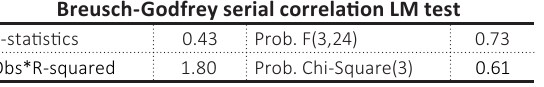
Table 6. Serial correlation test for private sector credit and growth finance